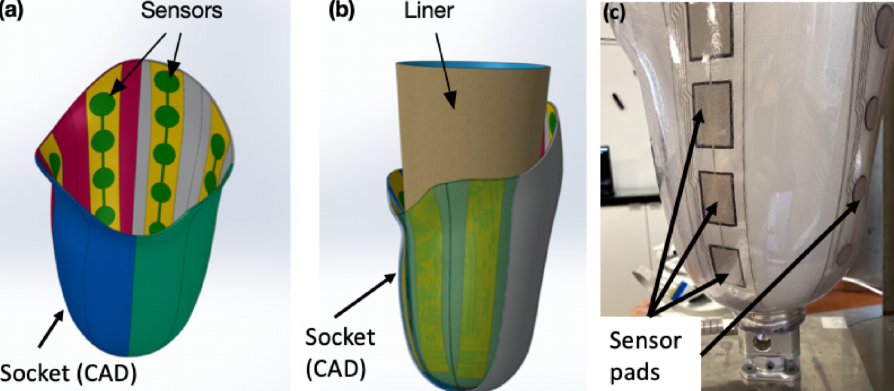
Figure 1. Socket with sensors: ( a ) CAD of sensors on the inner wall; ( b ) CAD of liner with socket; ( c ) actual socket with SocketSense sensors.